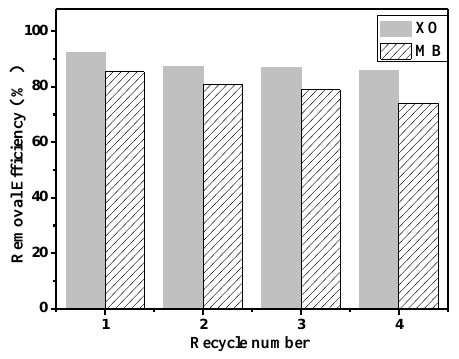
Figure 8. The dye removal efficiency of XO and MB after three desorption-adsorption cycles.